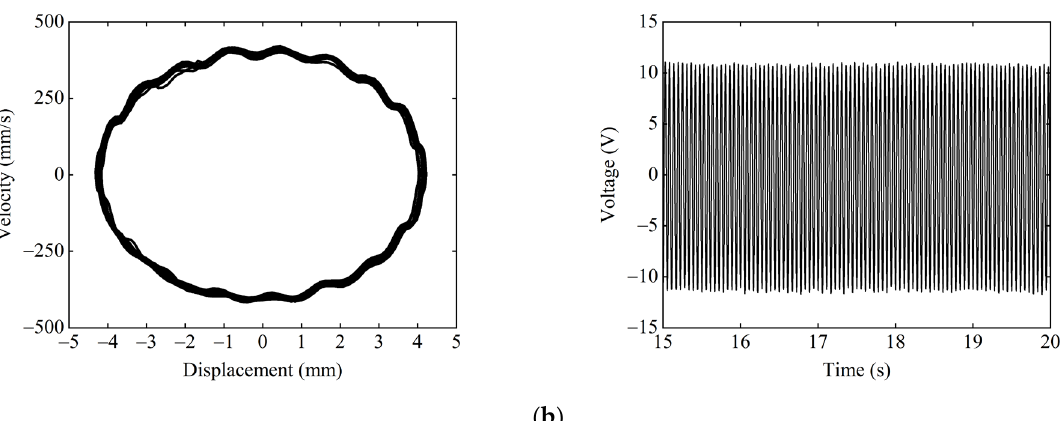
Figure 17. Experimental phase portrait and time–voltage diagram at different excitation frequencies: ( a ) F = 9 Hz; and ( b ) F = 18 Hz